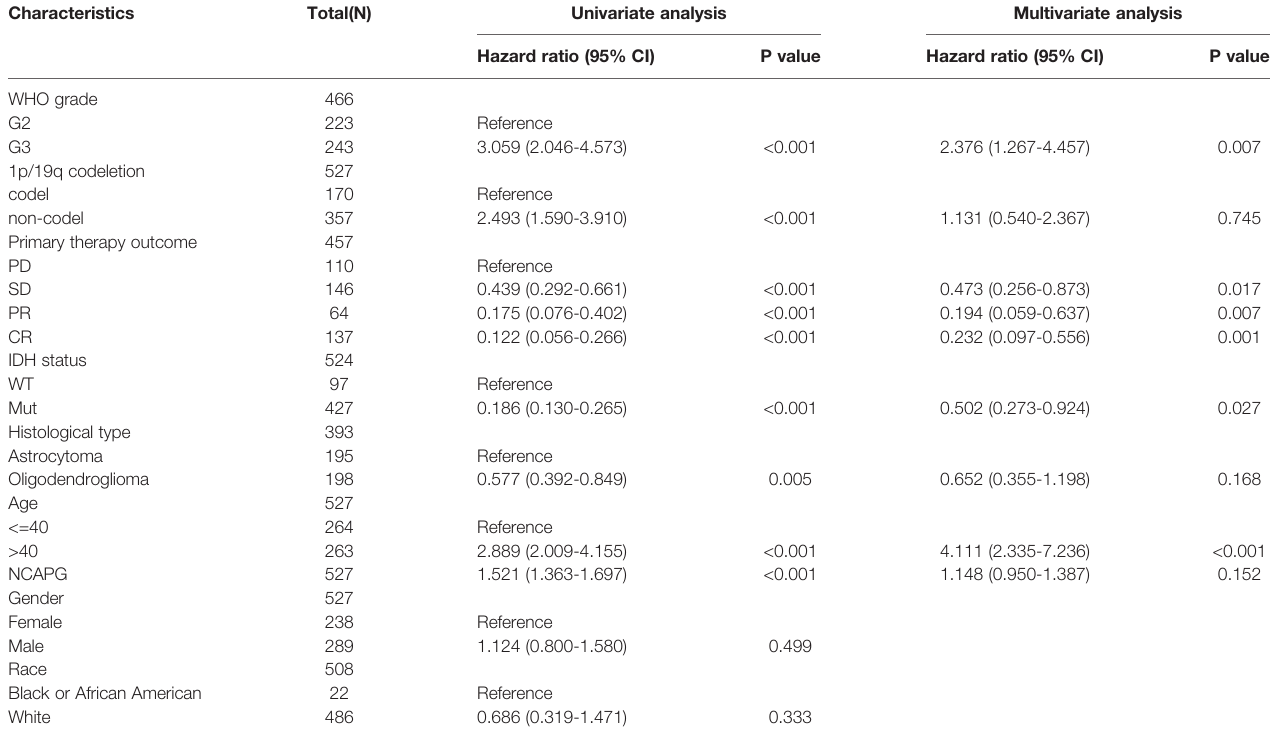
TABLE 3 | Univariate regression and multivariate survival model of prognostic covariates in patients with glioma.